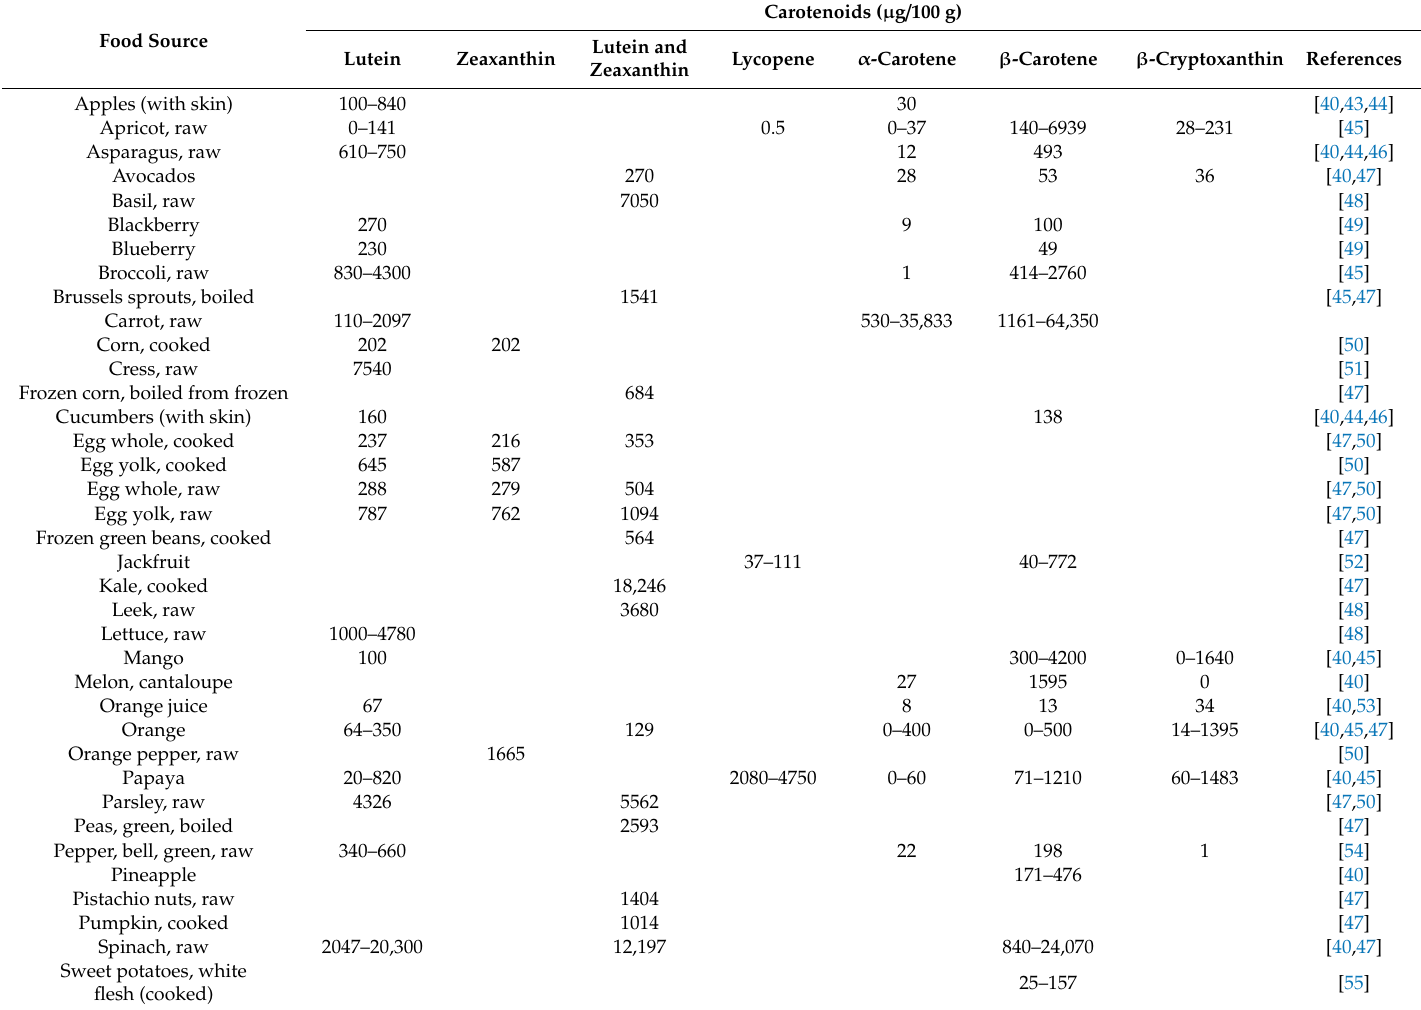
Table 1. Carotenoids content in some common